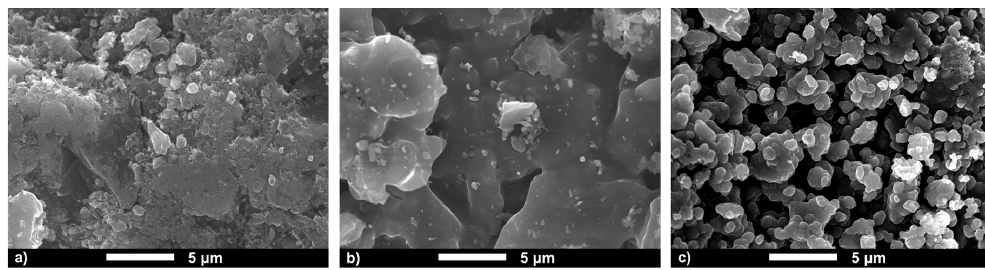
Figure 1 . Scanning electron microscopy images of activated carbon C40/4 Extra ( a ) uncoated, ( b ) coated with silicon dioxide (SiO 2 ) and ( c ) coated with silicon carbide